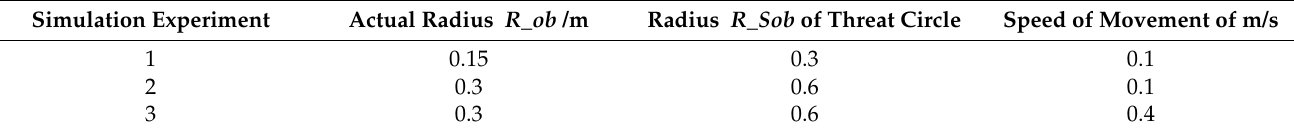
Table 7. Mobile obstacle movement